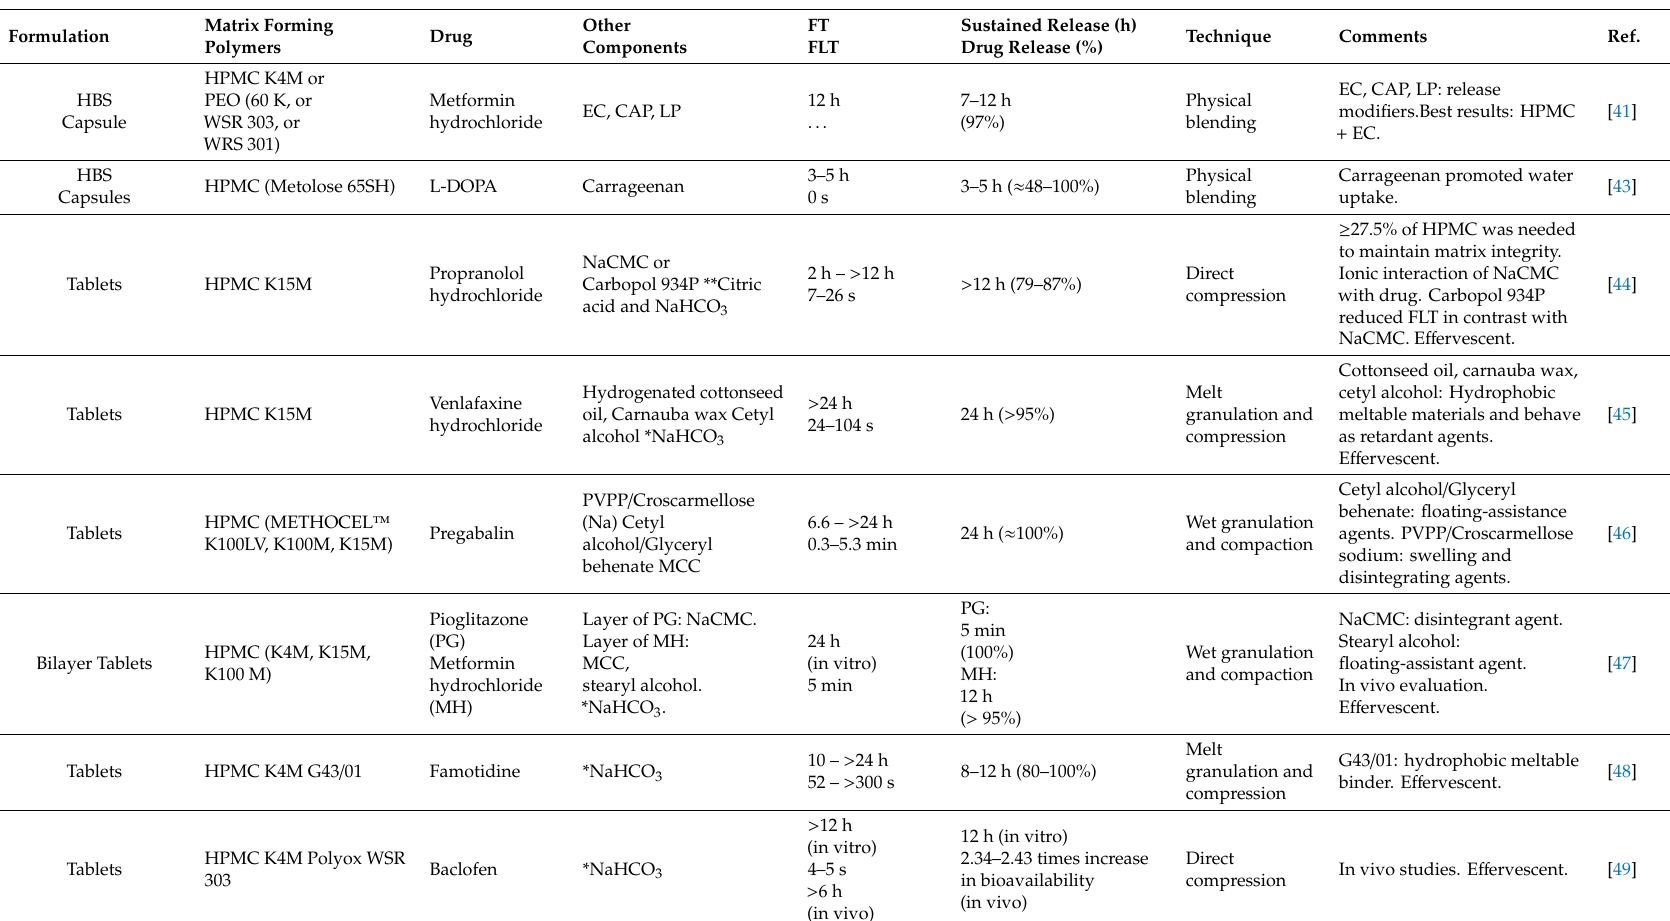
Table 3. Selected examples of single-unit low-density